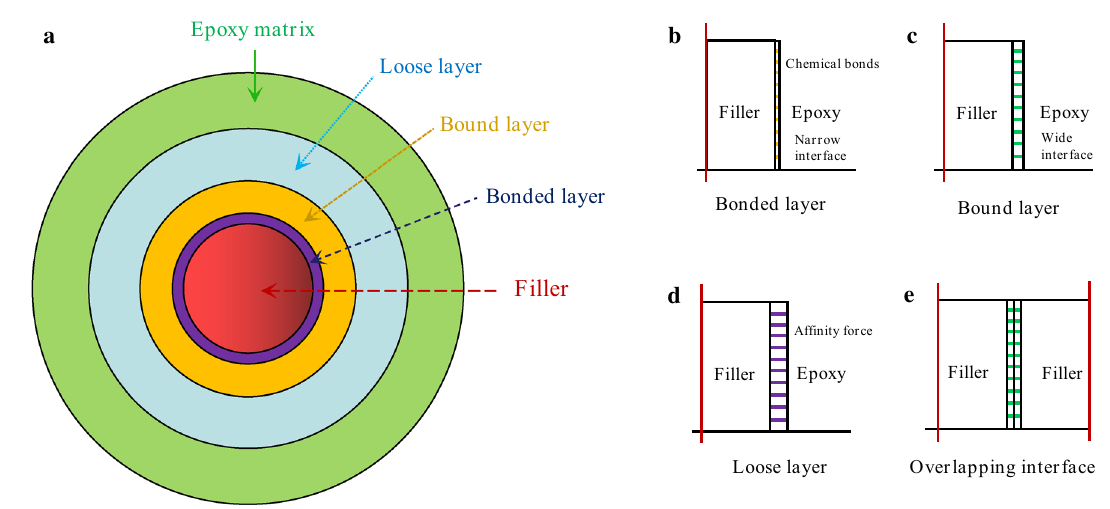
Figure 8. Interface strucrures in a similar multi-core model for epoxy